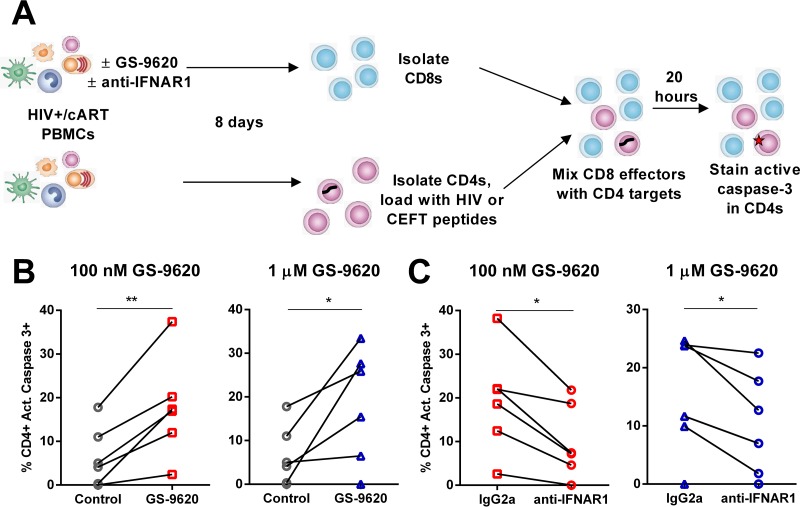
Polyfunctional CD8+ T cells generated by GS-9620 exhibit cytotoxic activity. (A) PBMCs isolated from ART-suppressed HIV-infected individuals (n = 6) were stimulated with a pool of HIV peptides (Gag, Pol, Env, and Nef) with or without the indicated concentrations of GS-9620 for 8 days before assessment of killing capacity. Either anti-IFNAR1 or isotype IgG2a antibody was added to the cultures. CD8+ T cells were isolated and cocultured with autologous CD4+ T cells pulsed with HIV peptides for 20 h at an effector/target ratio of 5:1. (B) CD4+ T cells pulsed with control peptides were used to assess nonspecific killing of cells that did not display HIV antigen. After 20 h of coculture, the cells were stained for active caspase 3 in target CD4+ T cells and analyzed by flow cytometry. Shown are the percentages of HIV-specific CD4+ T cells expressing active caspase 3. HIV-specific values were obtained by subtracting the corresponding percentage of marker-positive cells in control peptide-pulsed targets from HIV peptide-pulsed targets. (C) Cells were treated with anti-IFNAR1 or isotype control antibody at the same time as GS-9620 and maintained throughout the 8 days of stimulation. Each symbol indicates data from a single subject. The P values were determined by paired Student's t tests. *, P < 0.05; **, P < 0.01.